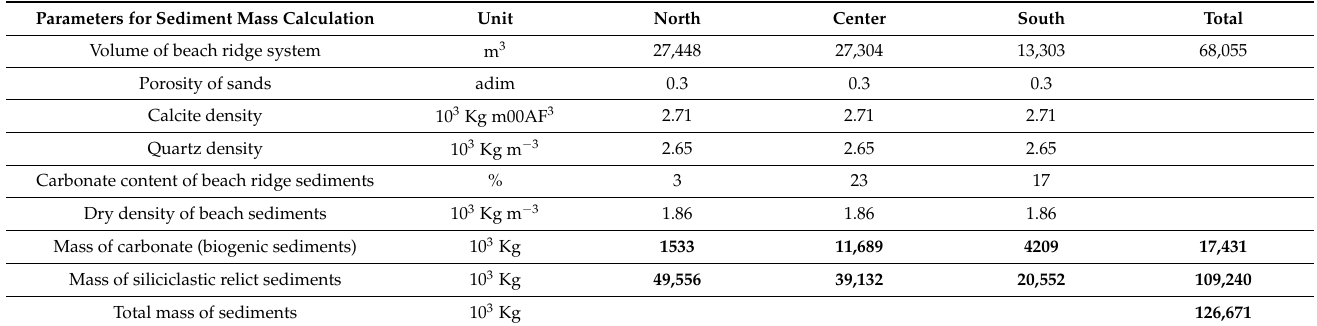
Table 2. Mari Ermi beach sediment budget calculated for each sector and for the whole system and parameters used for the calculation.